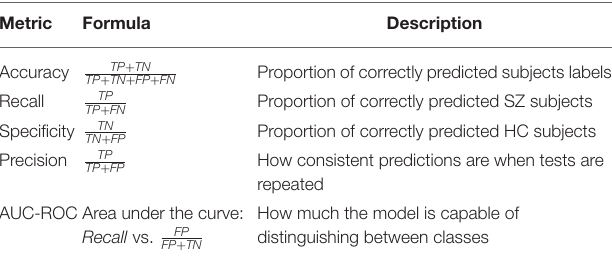
TABLE 1 | Metrics used to assess the model’s performance, their formulas, and descriptions.